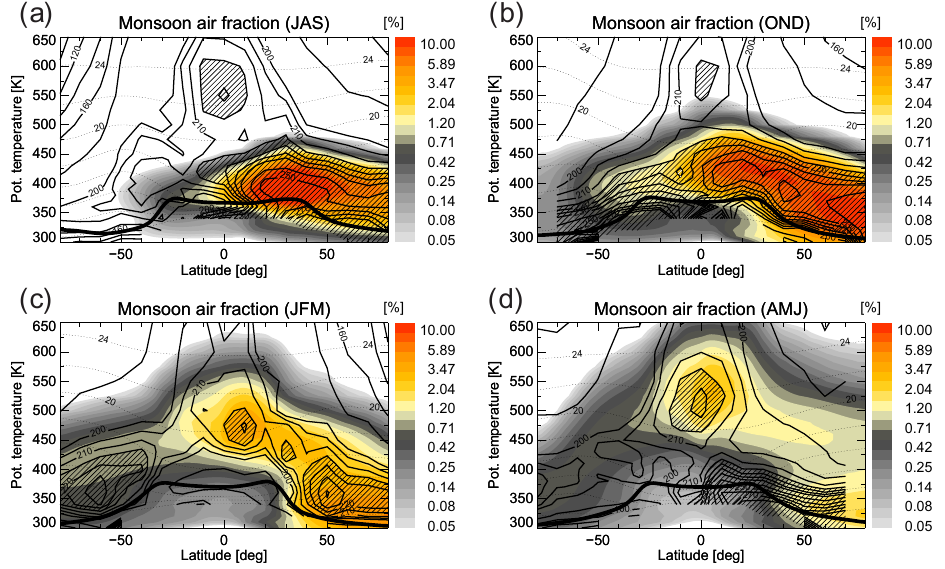
Figure 1. Seasonal evolution of climatological (2010–2013) zonal mean monsoon air mass fraction from CLaMS (color-coded) and HCN from ACE-FTS observations (black contours) during July–September (a) , October–December (b) , January–March (c) , and April–June (d) . Regions with HCN values above 215pptv are hatched. The thick black line shows the (WMO) tropopause, and thin black lines show altitude levels (2km